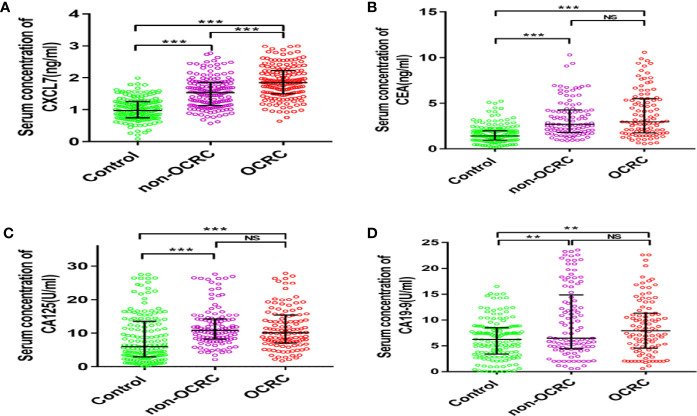
Comparison of the expression of serum CXCL7 and tumor-associated antigens in patients with non-OCRC, OCRC and health control group. (A) Serum CXCL7 (Kruskal–Wallis test: non-OCRC vs the control, OCRC vs the control and non-OCRC vs OCRC, all P < 0.001, n = 160, 156, 156 respectively). (B) Serum CEA (Kruskal–Wallis test: non-OCRC vs the control P < 0.001; OCRC vs the control P < 0.001 and non-OCRC vs OCRC P > 0.05, n = 158, 99, 99 respectively). (C) Serum CA125 (Kruskal–Wallis test: non-OCRC vs the control P < 0.001; OCRC vs the control P < 0.001 and non-OCRC vs OCRC P >0.05, n = 157, 115, 115 respectively). (D) Serum CA19-9 (Kruskal–Wallis test: non-OCRC vs the control P < 0.01; OCRC vs the control P < 0.01 and non-OCRC vs OCRC P > 0.05, n = 152, 105, 99 respectively). **P < 0.01, ***P < 0.001, NS, no statistical significance.